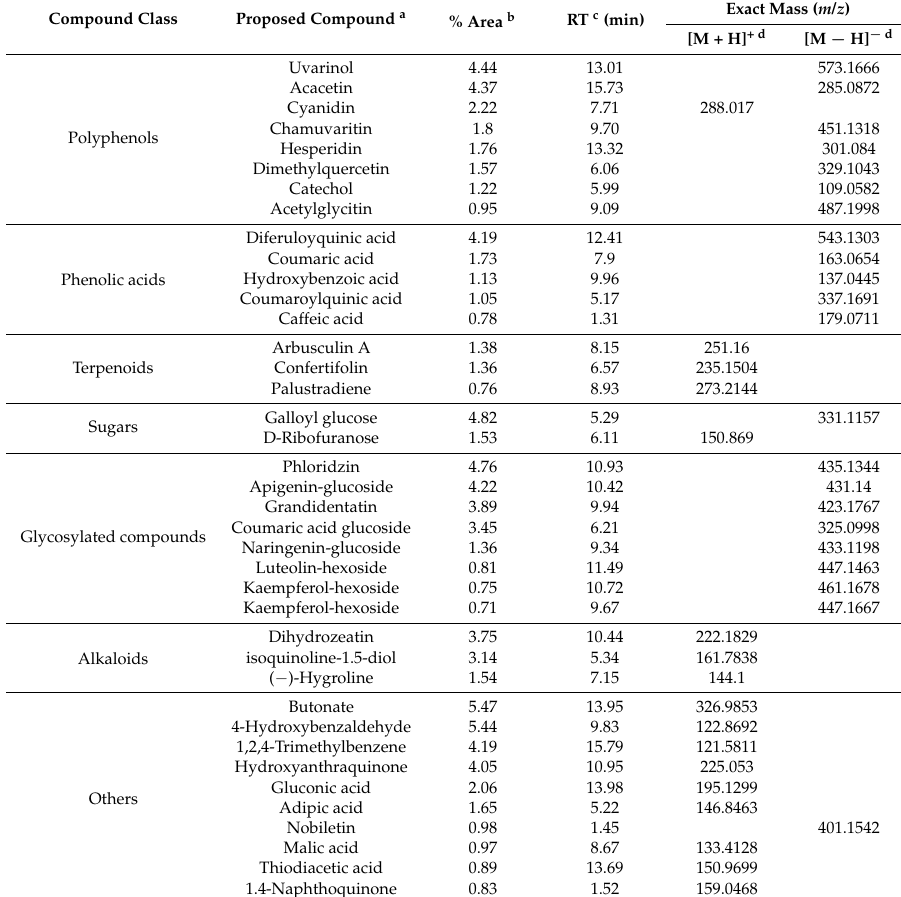
Table 2. Summary of the characterization of quaking aspen compounds of interest identified from methanol extracts following UPLC-QTOF-MS